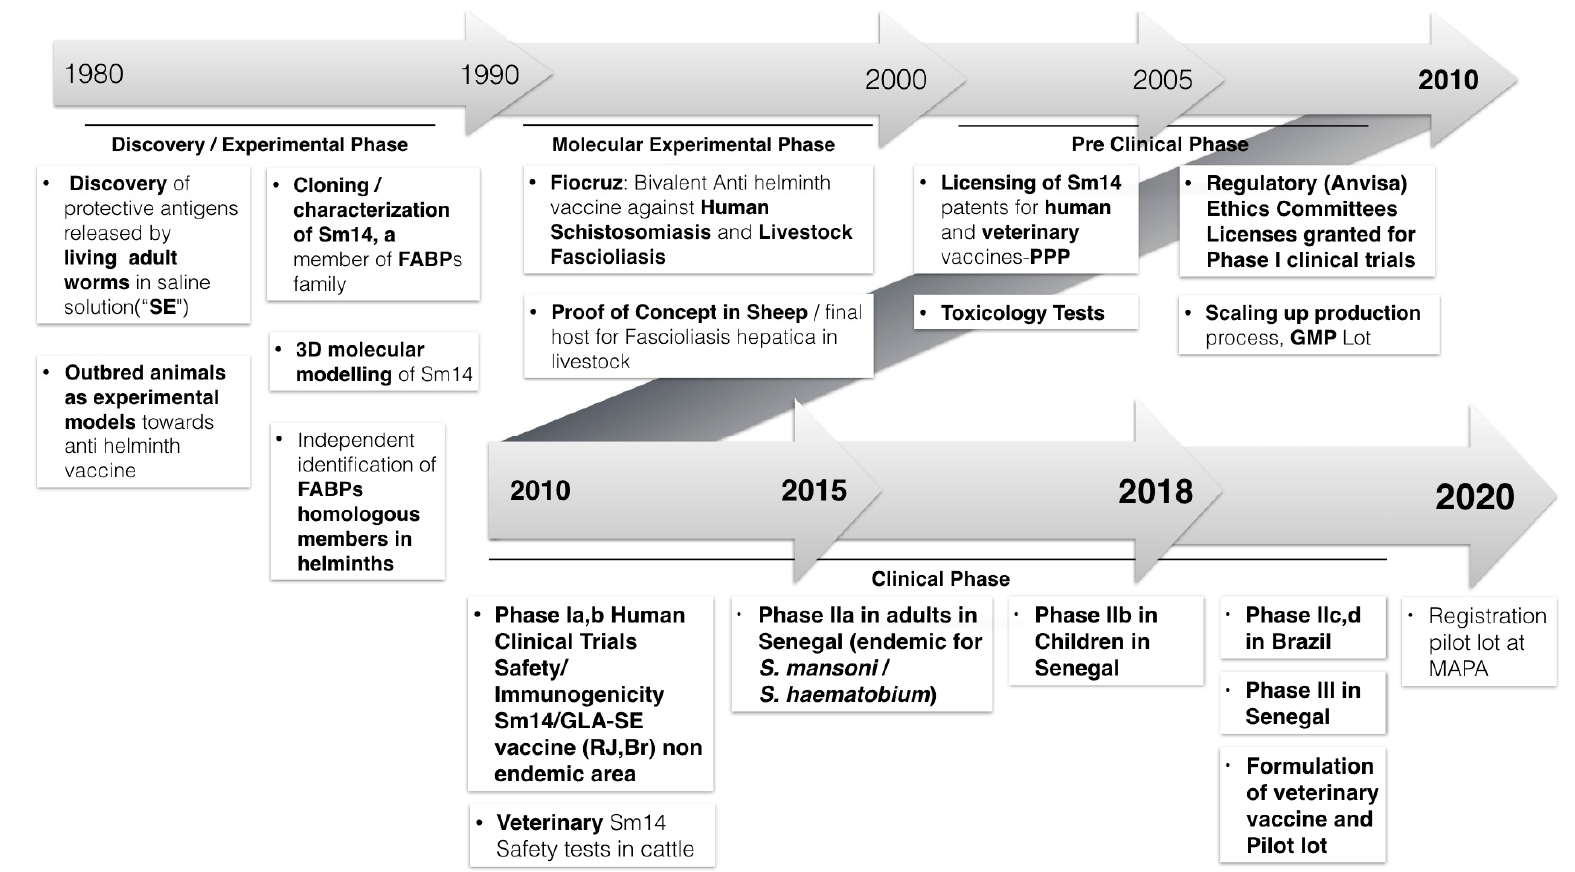
Figure 1. Timeline: Sm14/GLA-SE anti-schistosomiasis vaccine - from discovery phase to final product. MAPA: Brazilian Ministry of Agriculture.